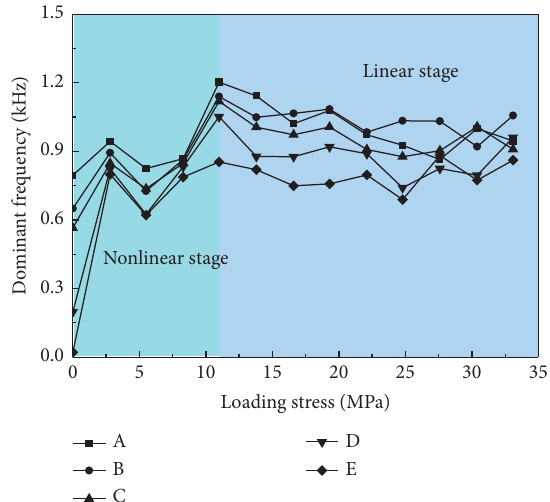
Table 2: Reorder of frequency band range.